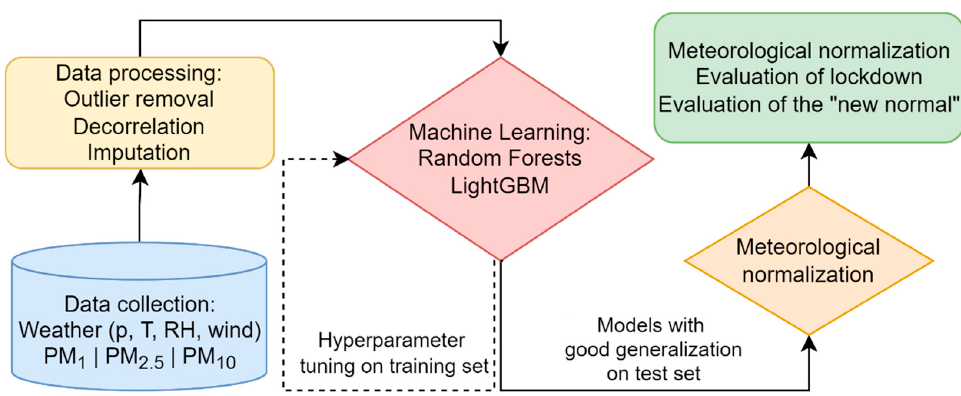
Figure 5. Schematics of the modelling procedure presented in this work.